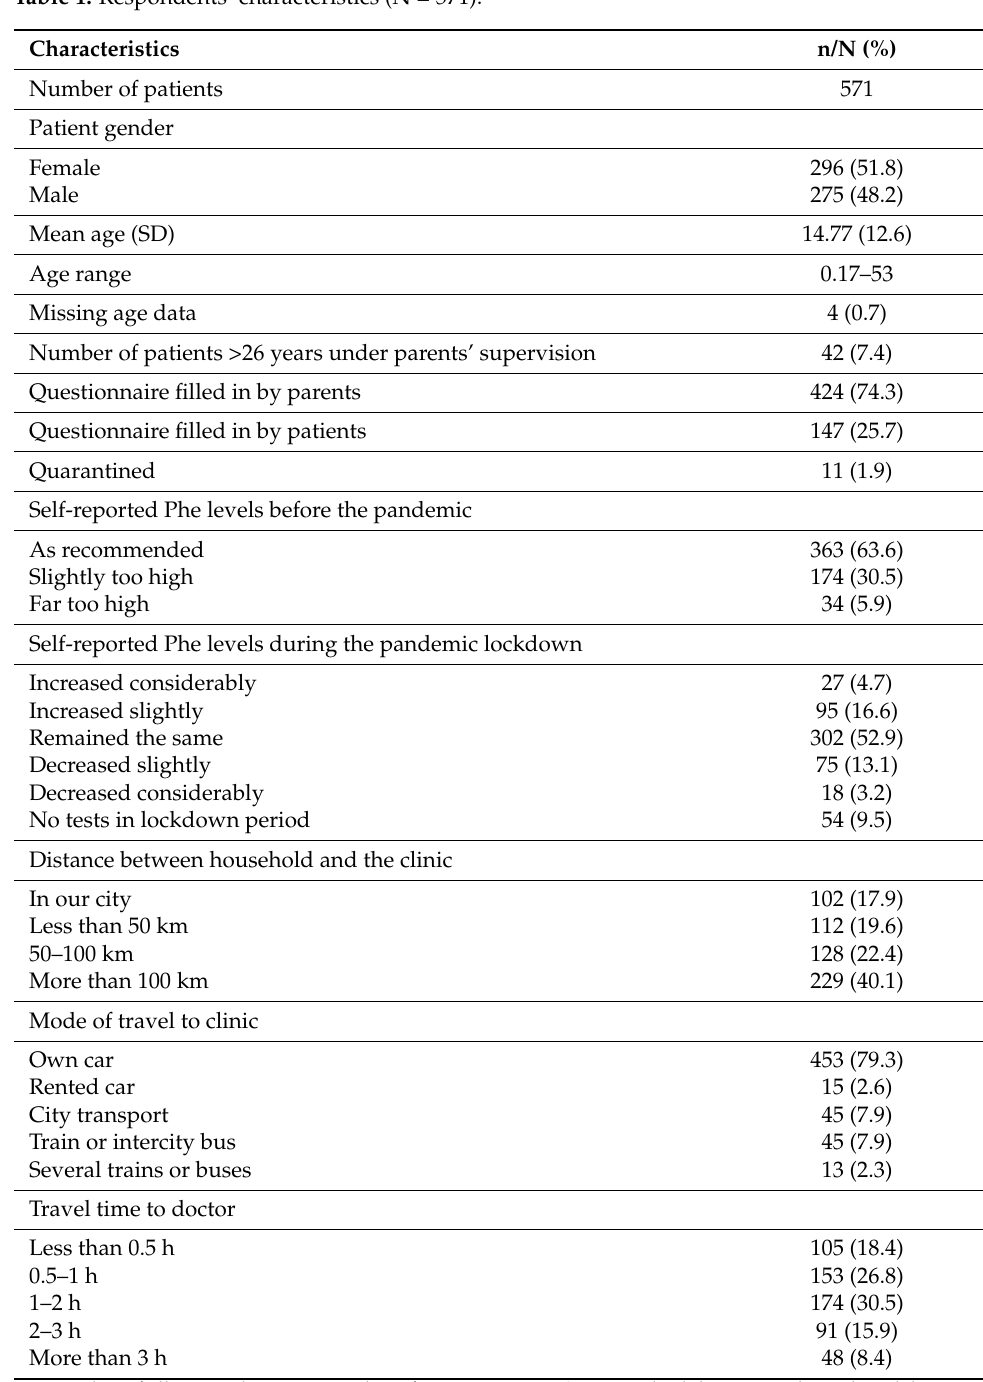
Table 1. Respondents’ characteristics (N =